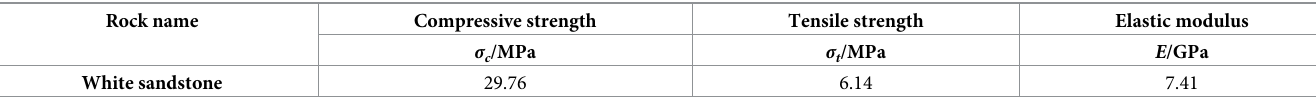
Table 1. Physical and mechanical parameters of white